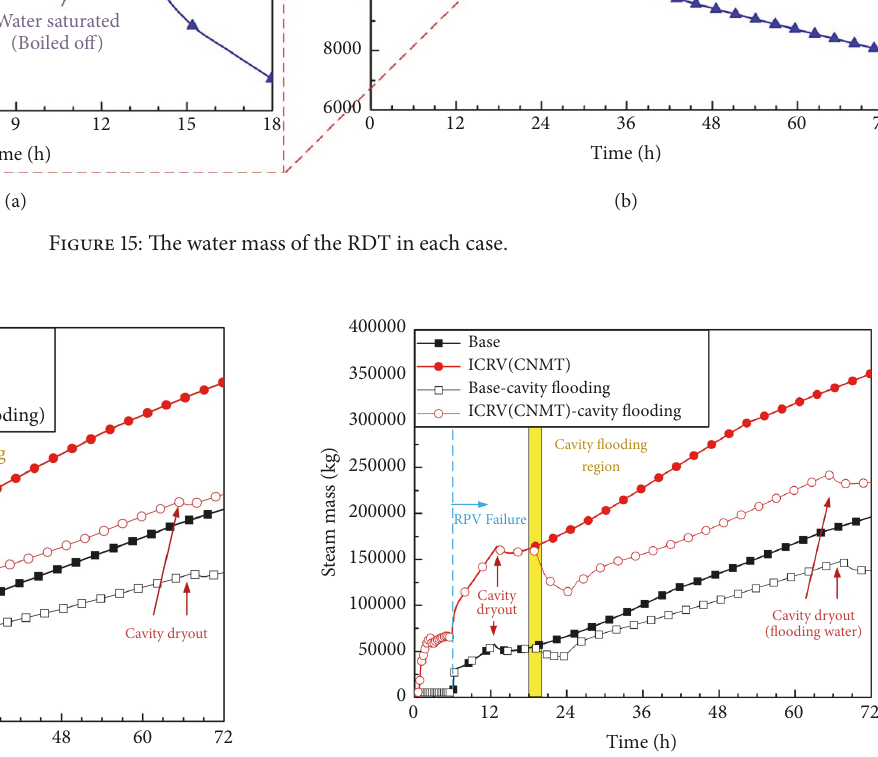
Figure 16: The effect of cavity flooding in the containment pressure.